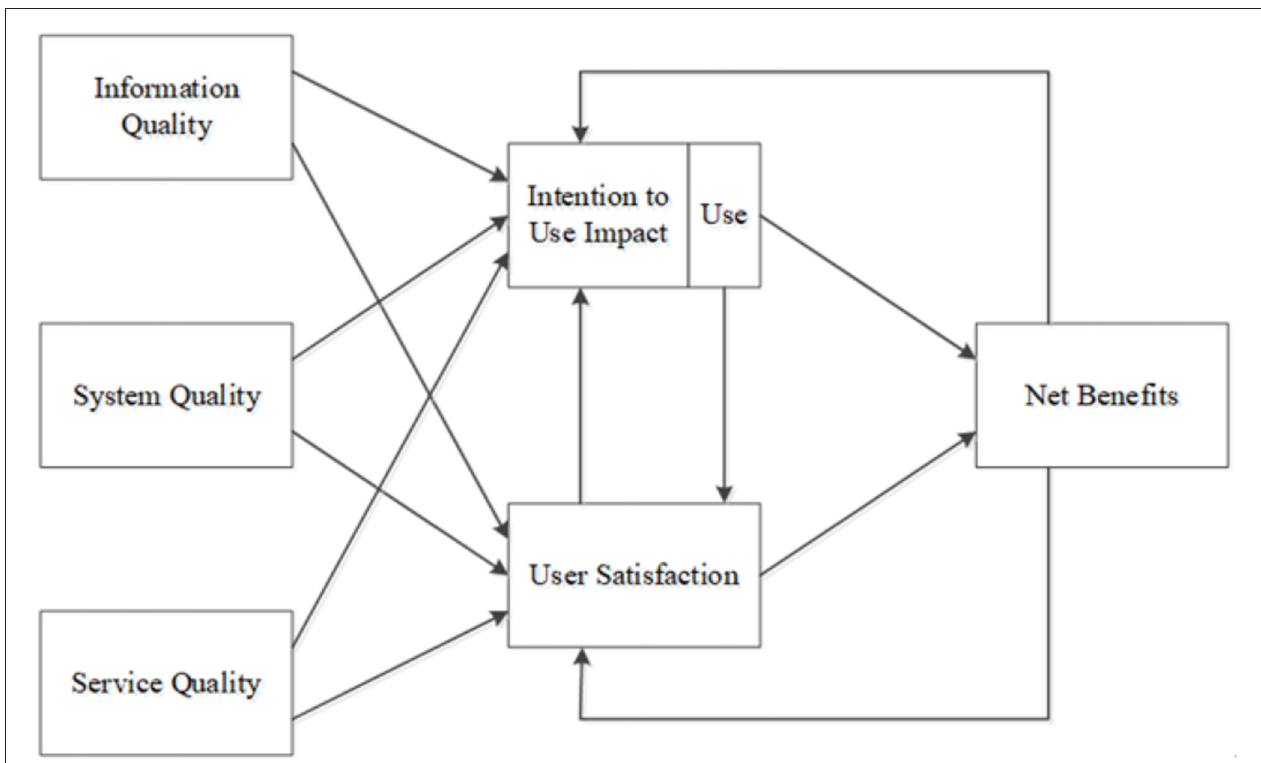
FIGURE 1 | Information system success model (DeLone and McLean,